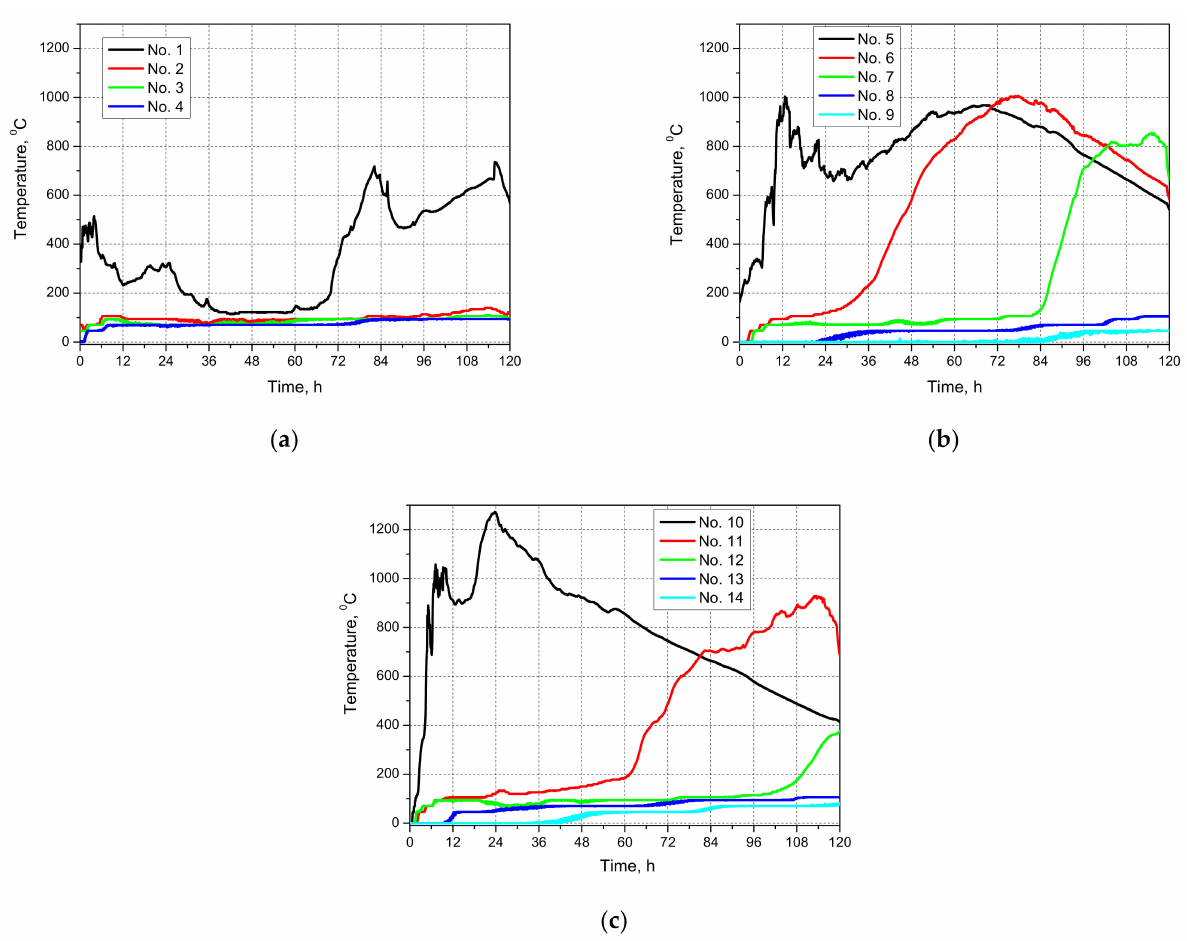
Figure 9. Temperature distribution during the Velenje gasification experiment: ( a ) gasification channel, ( b ) 0.3 m above bottom, ( c ) 0.6 m above